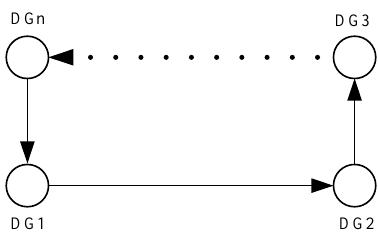
Figure 3. DG communication topology.